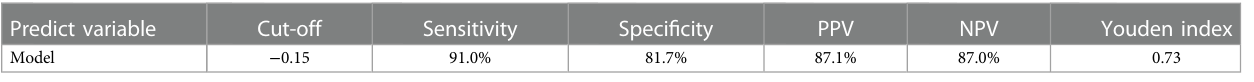
TABLE 4 The ROC curve